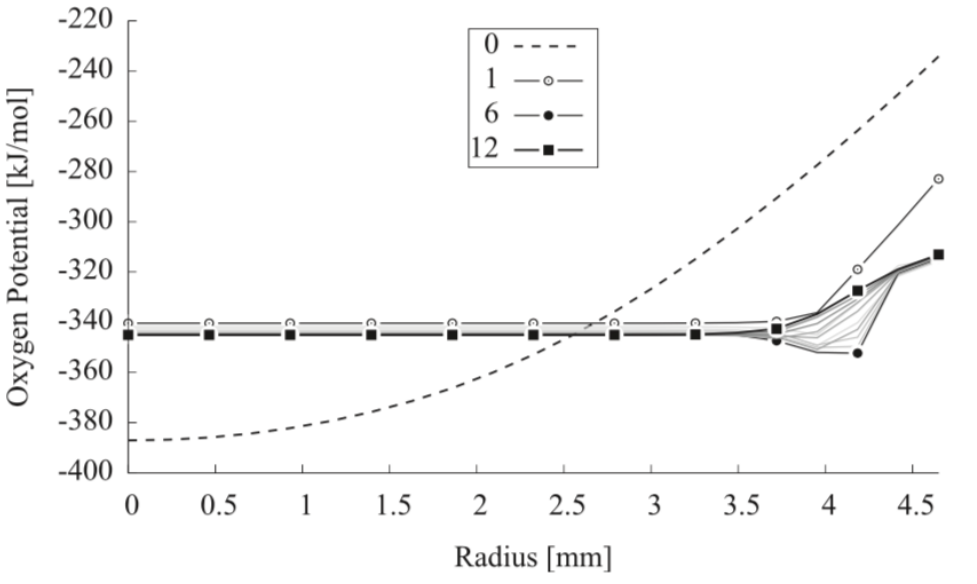
Figure 2. The predicted oxygen chemical potential across the radius of a PWR fuel pellet by Simunovic et al. is shown at different time intervals (months) [40].